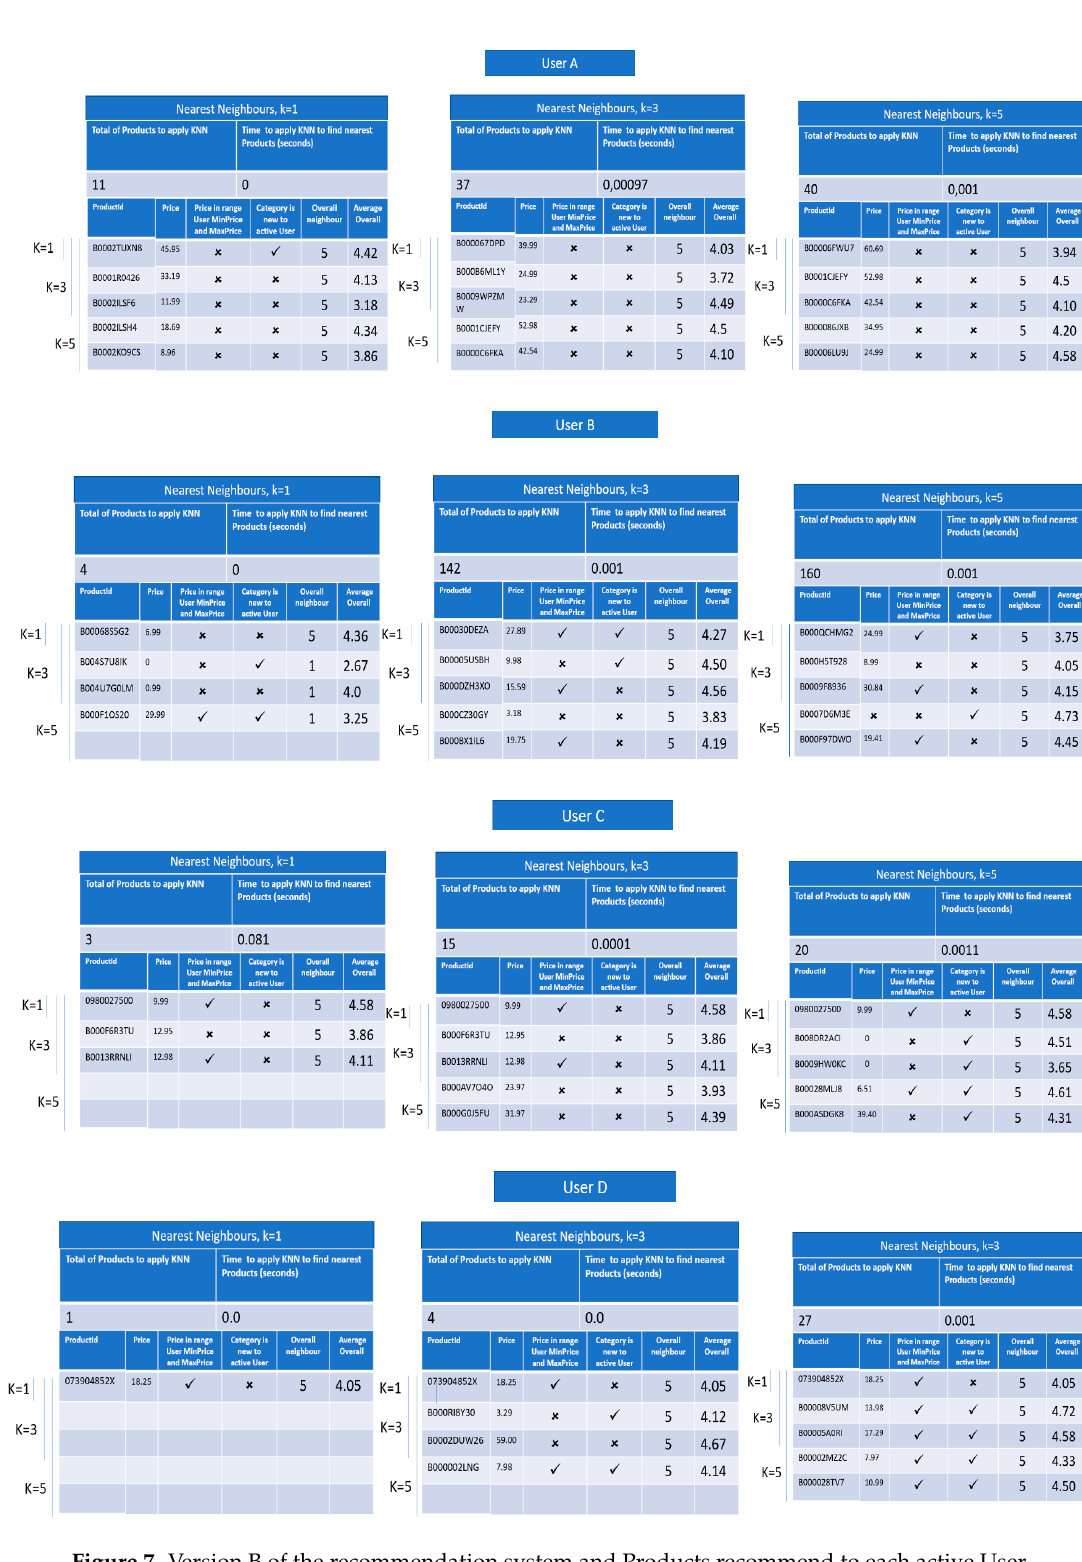
Figure 7. Version B of the recommendation system and Products recommend to each active User .